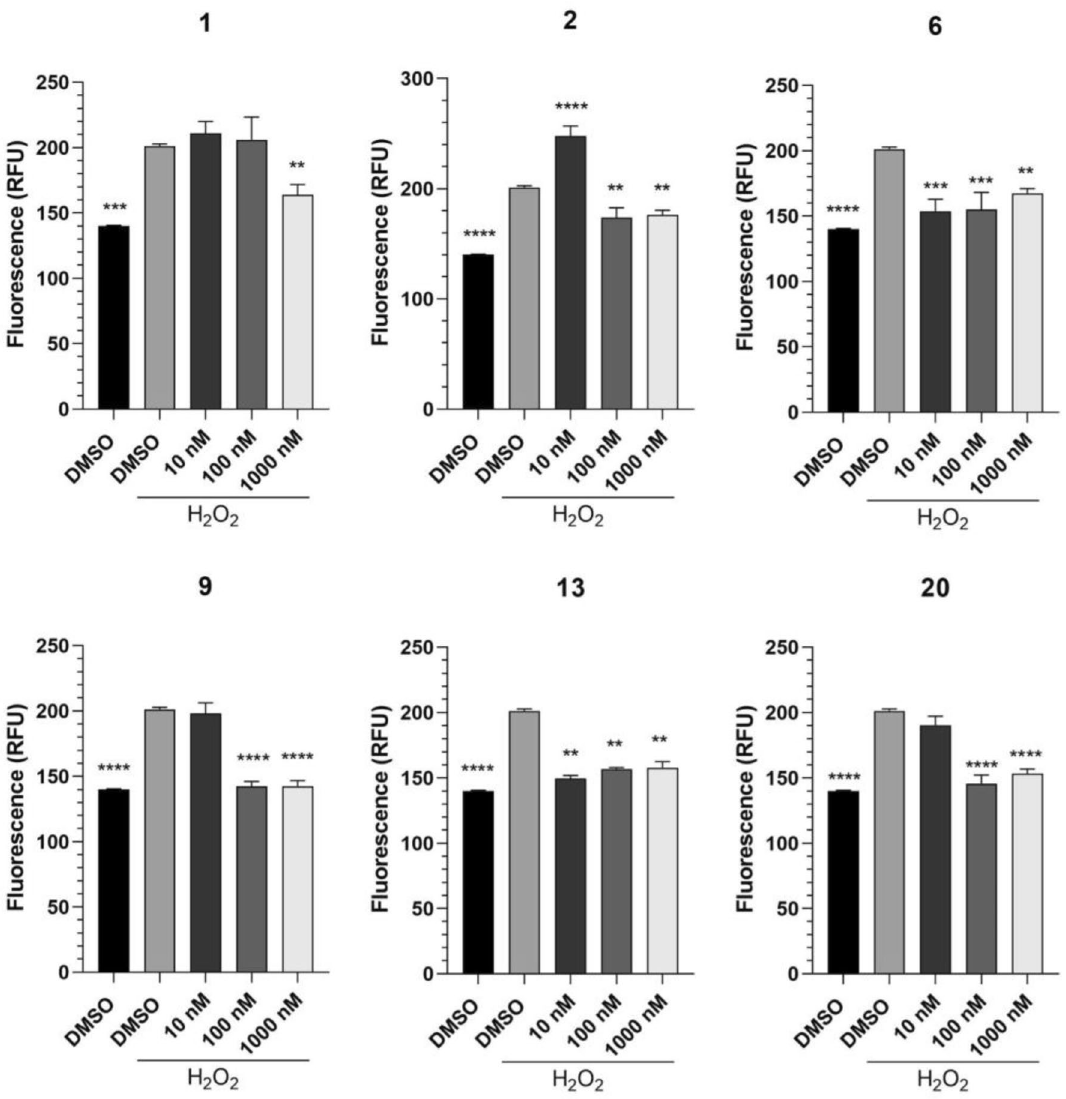
Figure 3. Selected metabolites abbreviated H 2 O 2 -induced oxidative stress in SH-SY5Y cells. Data are presented as means ± S.D. (n =